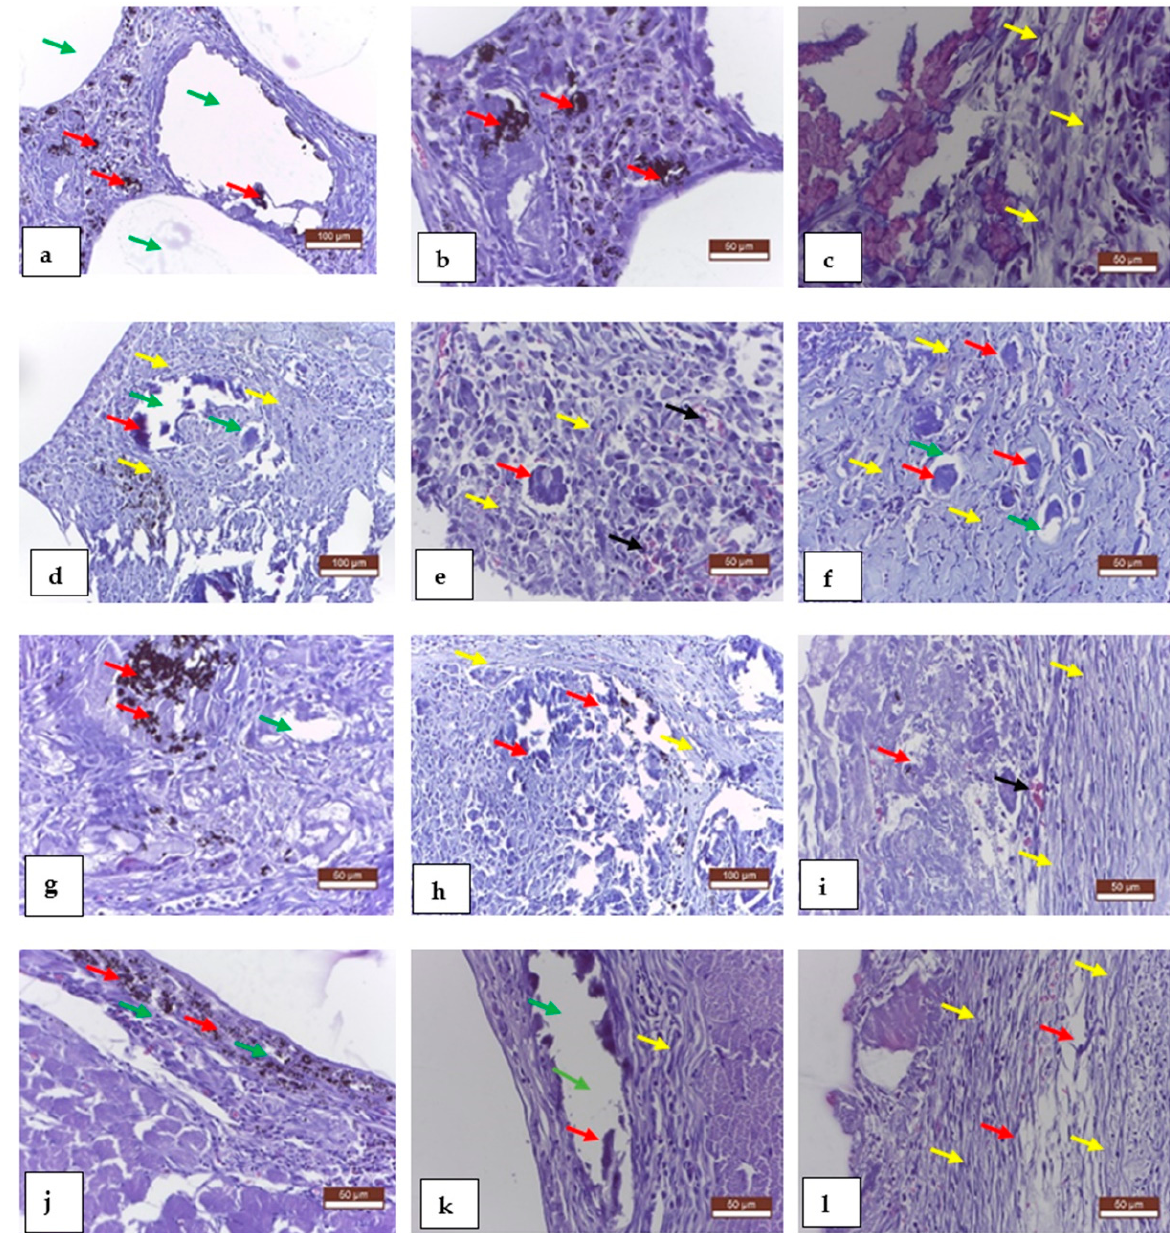
Figure 4. Rat tissue, representative results of histological examination, MTC staining, 1 week later ( a – c ), 2 weeks ( d – f ), 4 weeks ( g – i ), and 8 weeks ( j – l ). Mg-0.5Ca-xY alloy (red arrow), gas inclusions (green arrow), fibroblast collagen fibers (yellow arrow), and neovascularization (black